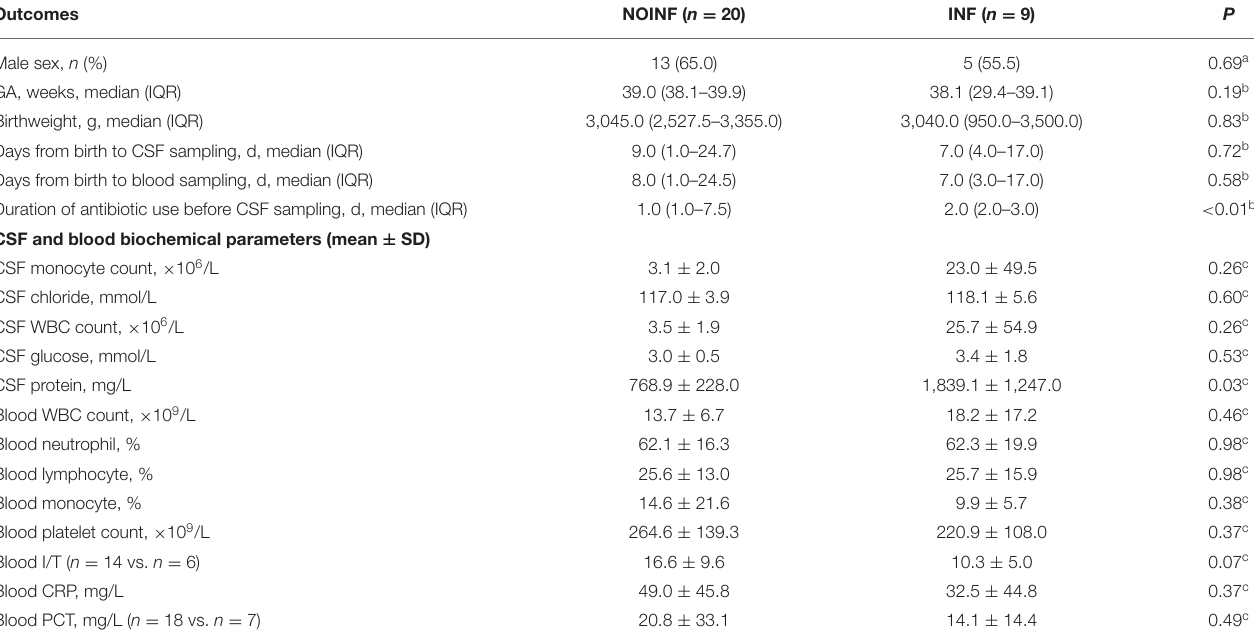
TABLE 1 | Basic characteristics of the infants included and their hematological and biochemical readouts. Outcomes